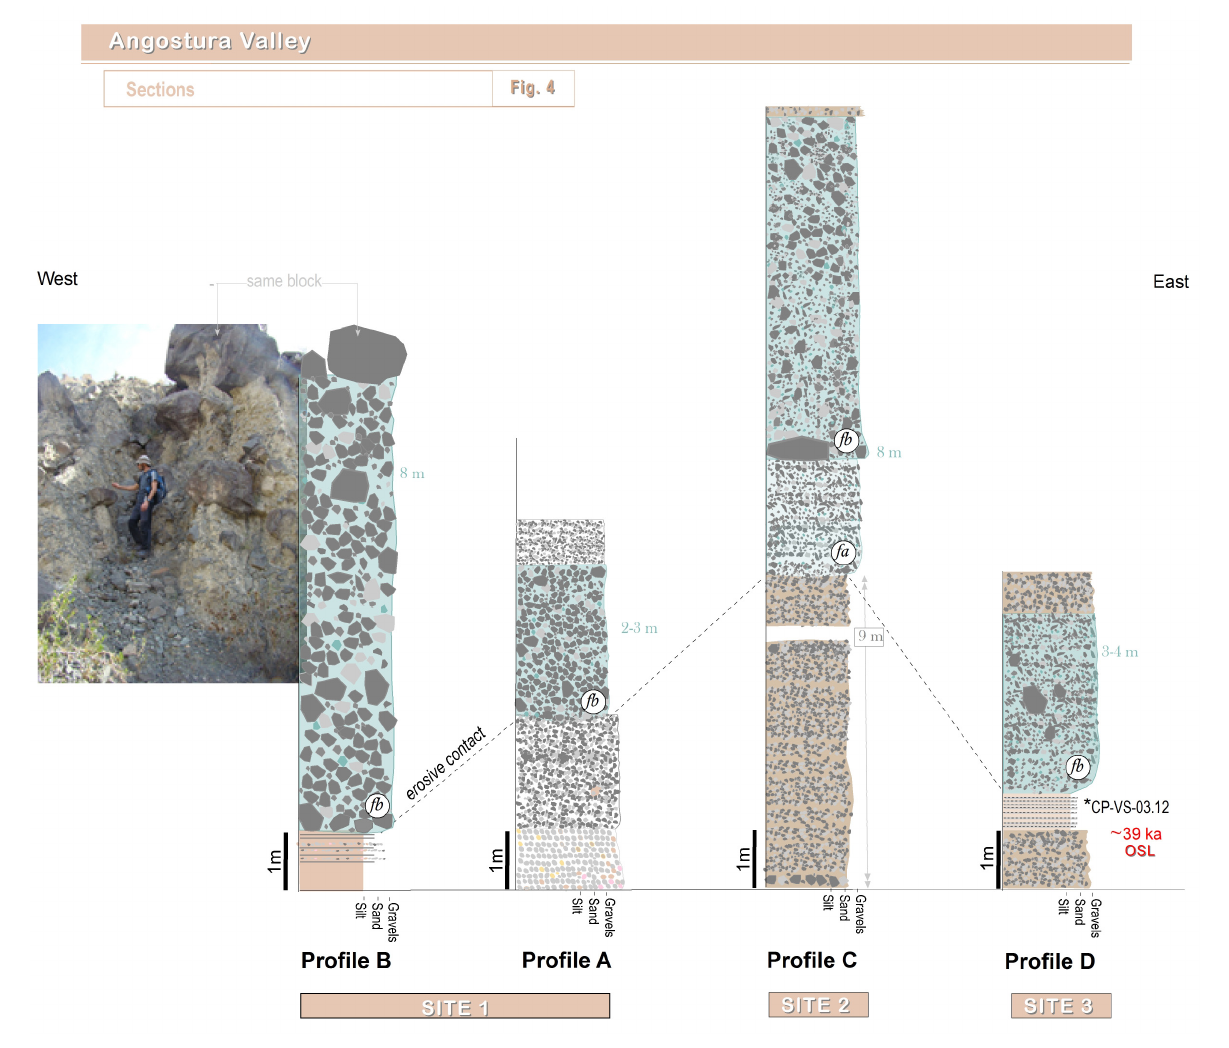
blocks are El Plata breccia, sandstone, and pelites; some